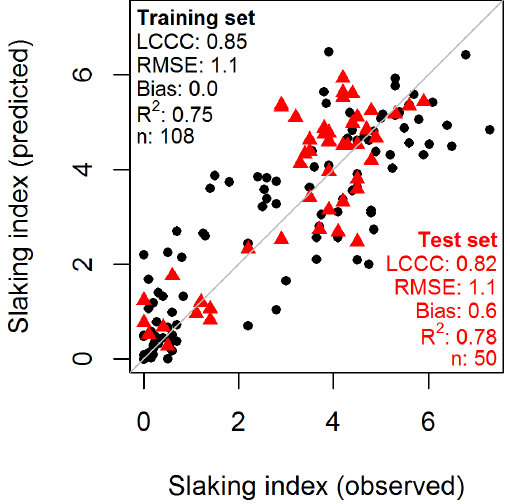
Figure 5. Plot of observed and predicted slaking index (SI) val- ues from regression kriging for two validation methods: (1) leave- one-out cross-validation (LOOCV) on the training set ( n = 108) and (2) external validation on an independent test set ( n = 50).